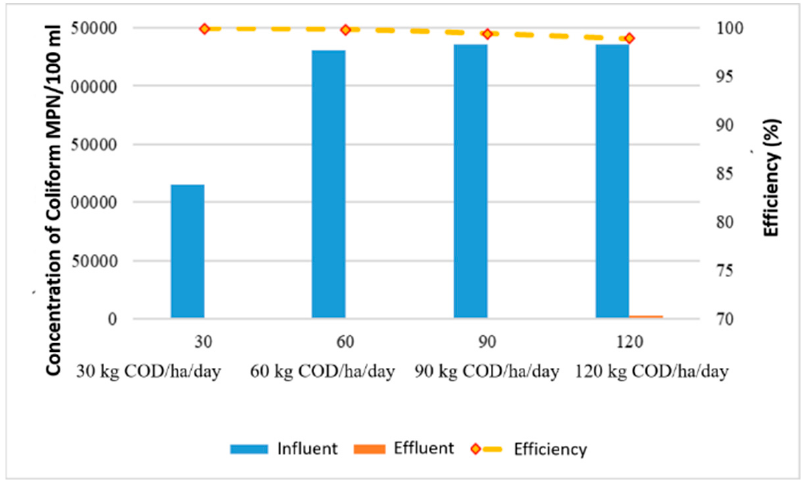
Figure 5. Effect of organic loading on Coliform removal efficiency.